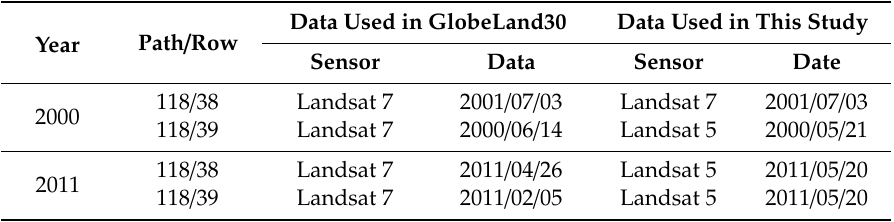
Table 2. Data used in the study.